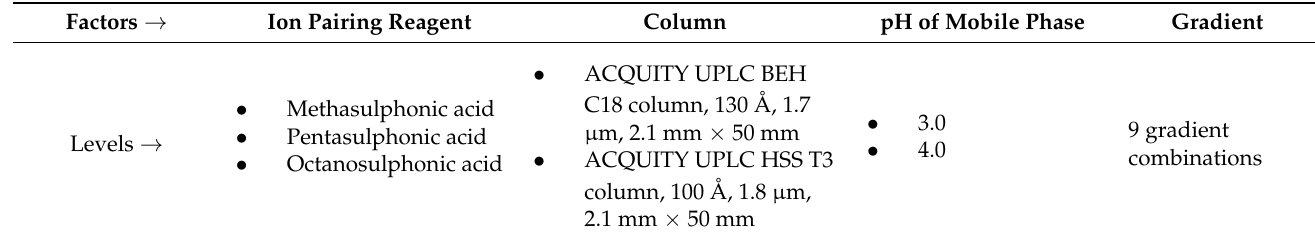
Table 2. Initial screening DoE for the assessment of CMePs.